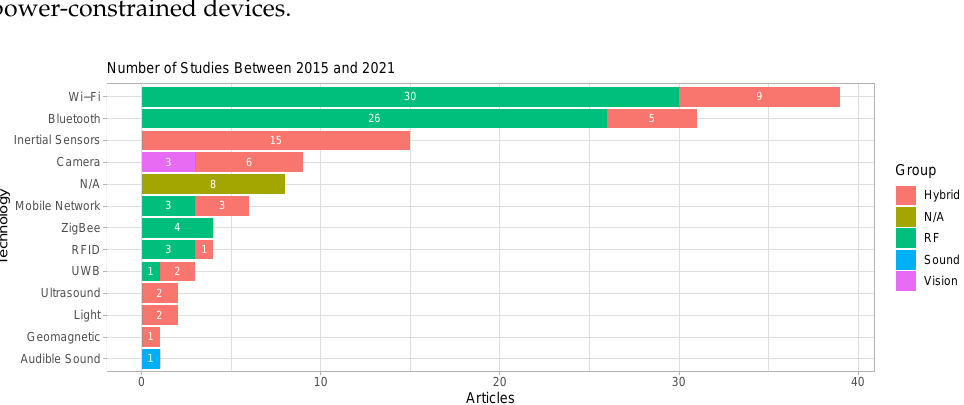
Figure 7. Indoor positioning technologies used in current